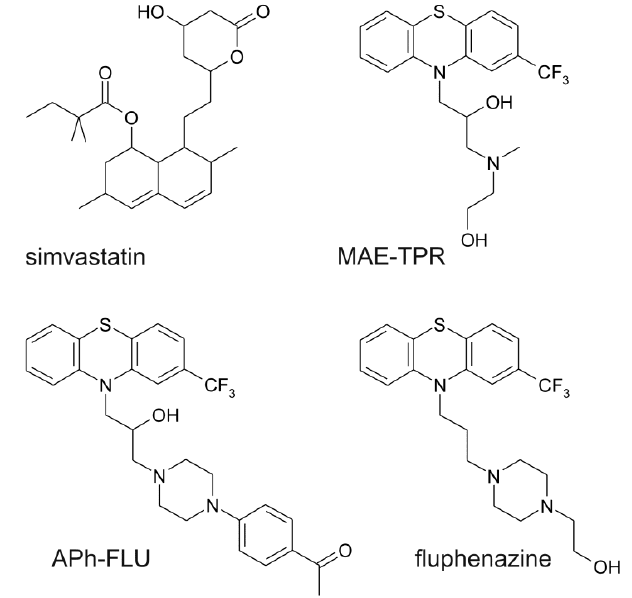
Figure 1. Chemical structures of the studied modulators.